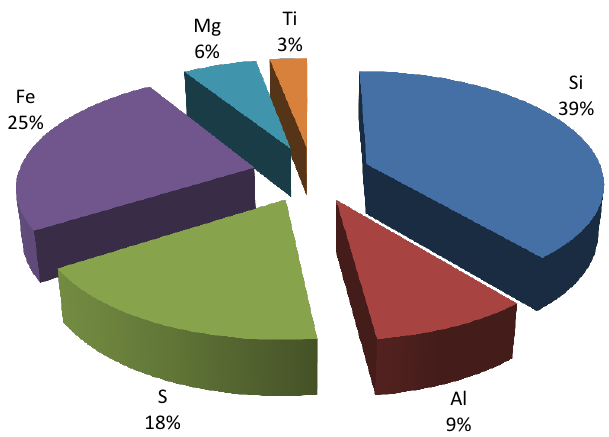
Figure 31. Average bulk elemental concentrations (in weight- percent) of PM 2 . 5 aerosols collected at 80m height between 7 March and 21 April